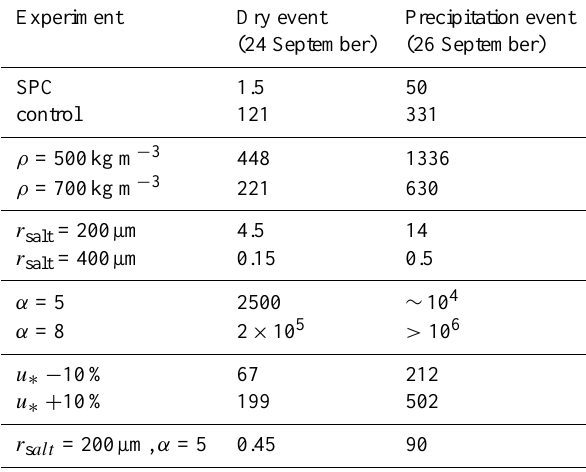
Table 2. Overview of simulations that analyse the sensitivity of the drifting snow model to its input parameters. Shown is the daily ac- cumulated snow transport at 1m above the surface in kgm − 2 during the two case